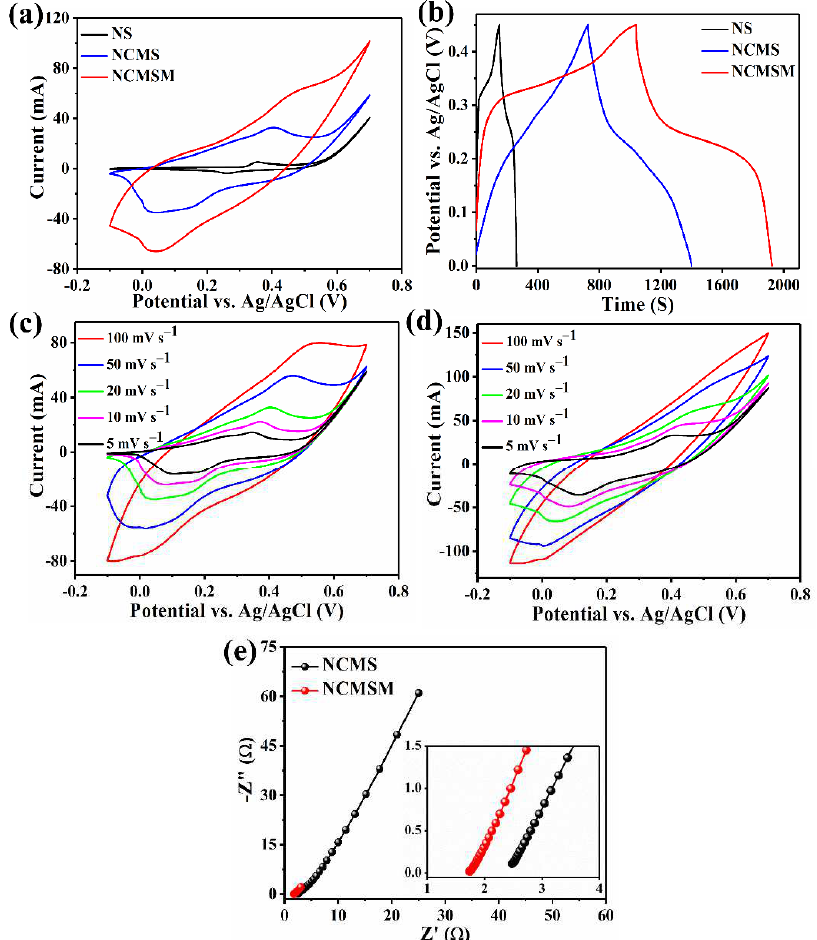
Figure 8. ( a ) CV curves at a scan rate of 20 mV s − 1 within the potential window − 0.1 to 0.7 V and ( b ) galvanostatic charge-discharge profiles at a current density of 1 A g − 1 within the potential window 0 to 0.45 V for NS, NCMS, and NCMSM; CV curves of ( c ) NCMS and ( d ) NCMSM at different scan rates within the potential window − 0.1 to 0.7 V; and ( e ) Nyquist plots of NCMS and NCMSM (inset: a magnified view of the high-frequency region); all measured in 1 M